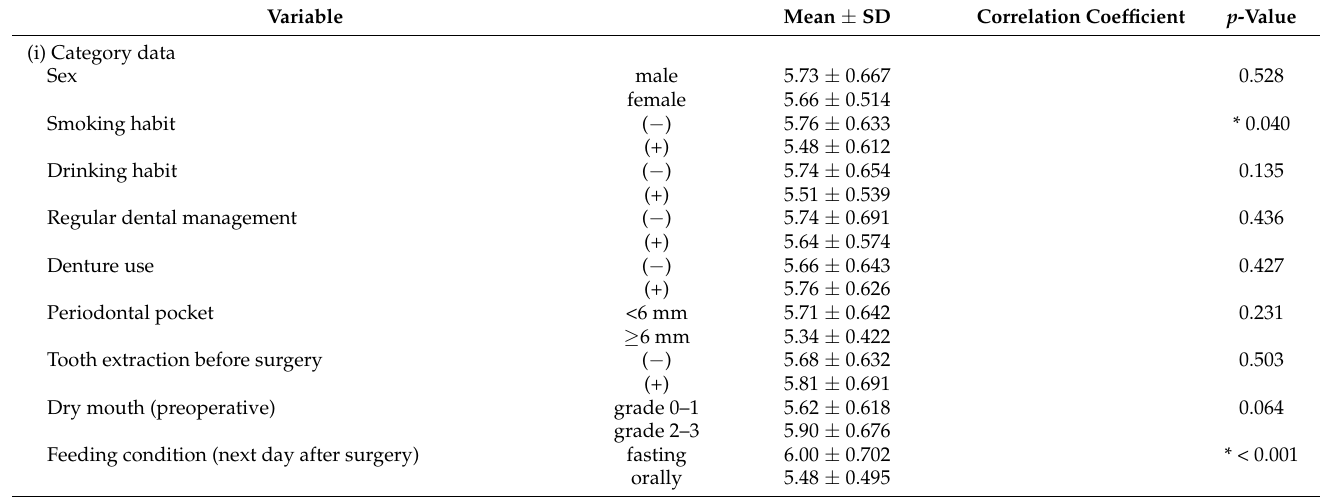
Table 4. Factors related to the number of bacteria in saliva on the day after surgery (univariate